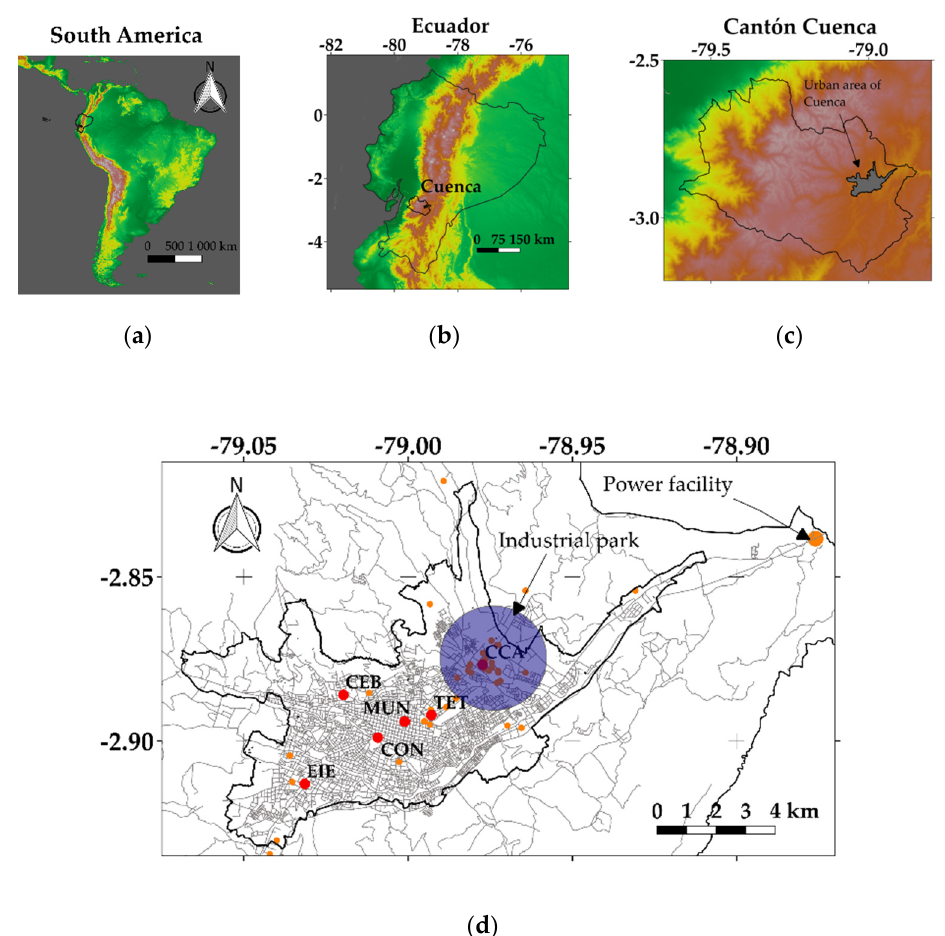
Figure 1. Location of: ( a ) Ecuador; ( b , c ) Cuenca; ( d ) urban area of Cuenca and the air quality stations (red dots) with PM 2.5 sensors (name, nomenclature): Colegio Carlos Arízaga, CCA; Terminal Terrestre, TET; Municipio, MUN; Condamine, CON, Cebollar, CEB; Escuela Ignacio Escandón, EIE. Orange dots indicate industries.